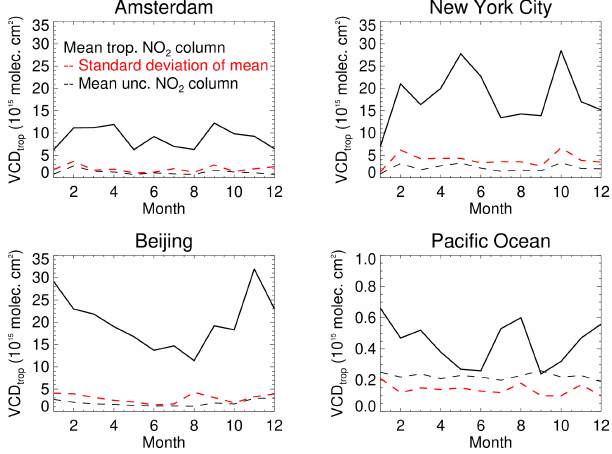
Figure 10. Monthly mean single grid-cell QA4ECV OMI tro- pospheric NO 2 columns (solid line), standard deviation of the mean (standard error, dashed red line), and super-observation uncertainty ( σ 0 , dashed black line) in 2005 over Amsterdam (52.375 ◦ N, 4.875 ◦ E), New York City (40.875 ◦ N, 73.875 ◦ W), Beijing (39.875 ◦ N, 116.375 ◦ E), and the Pacific (39.875 ◦ N, 149.875 ◦ W). Grid cell size of 0.25 ◦ × 0.25 ◦ . Only pixels with cloud radiance fraction <0.5 were included in the